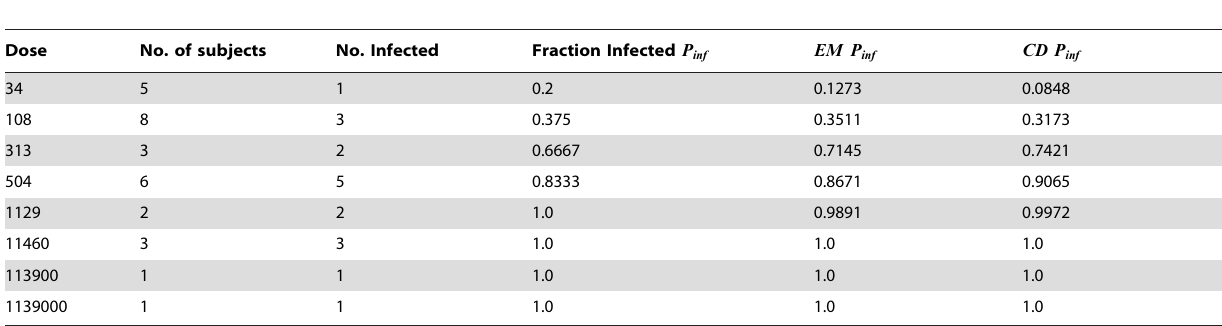
Table 2. Probability of infection from experimental data for Cryptosporidium parvum ( P inf ) compared to the probability of infection predicted by the Exponential model (EM) and the Cumulative Dose (CD)